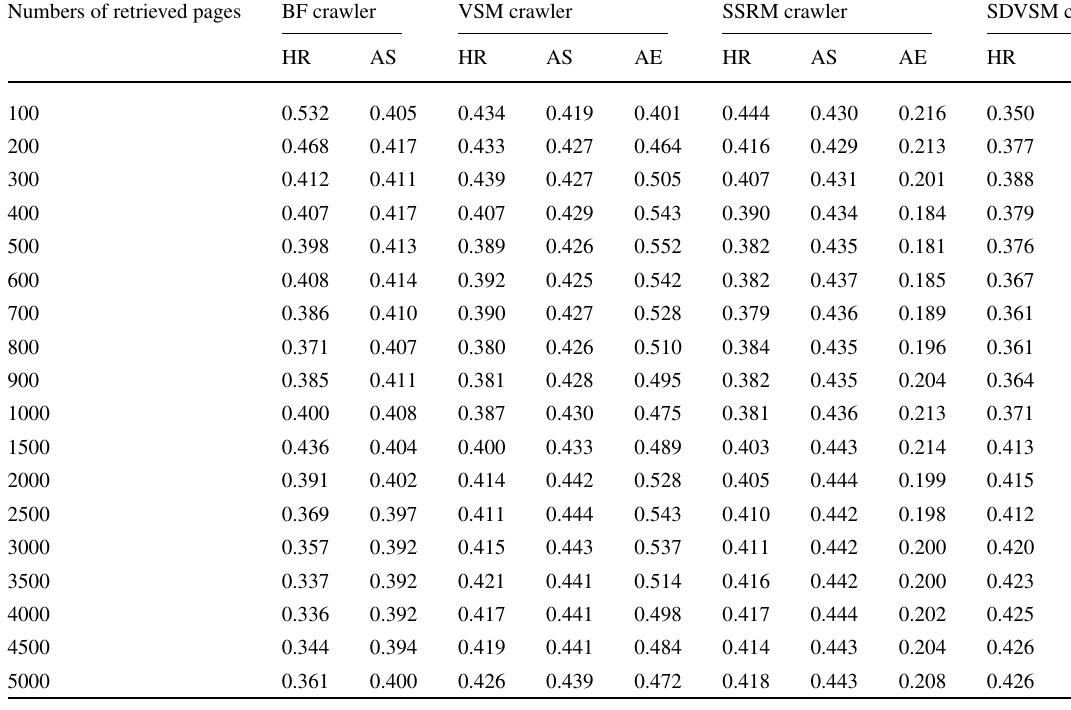
Fig. 10 The comparison of the harvest rate for four focused crawlers based on the second group